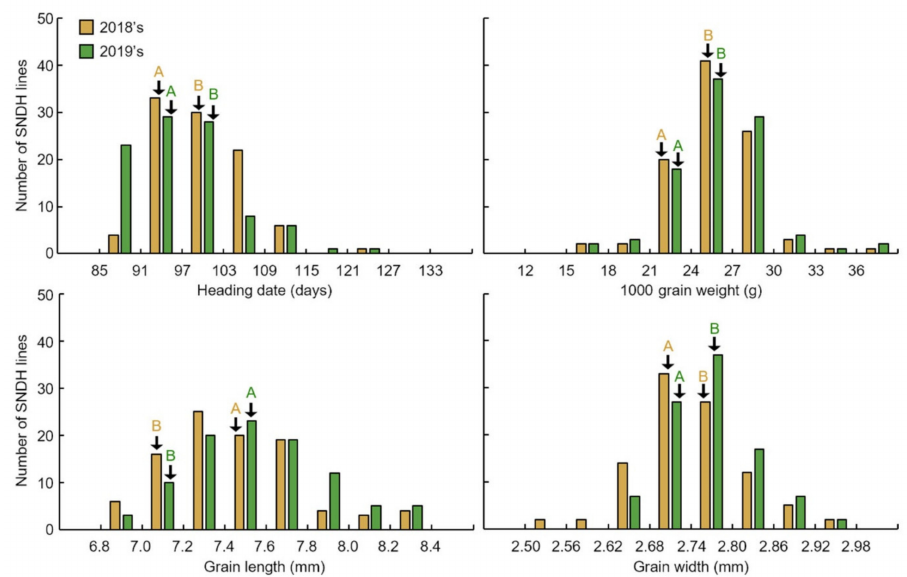
Figure 3. Frequency distribution for heading date, 1000 grain weight, grain length, and grain width in SNDH lines. Because all traits showed a normal distribution, the investigated traits can be considered quantitative traits. ( A ) Samgang; ( B ) Nagdong.